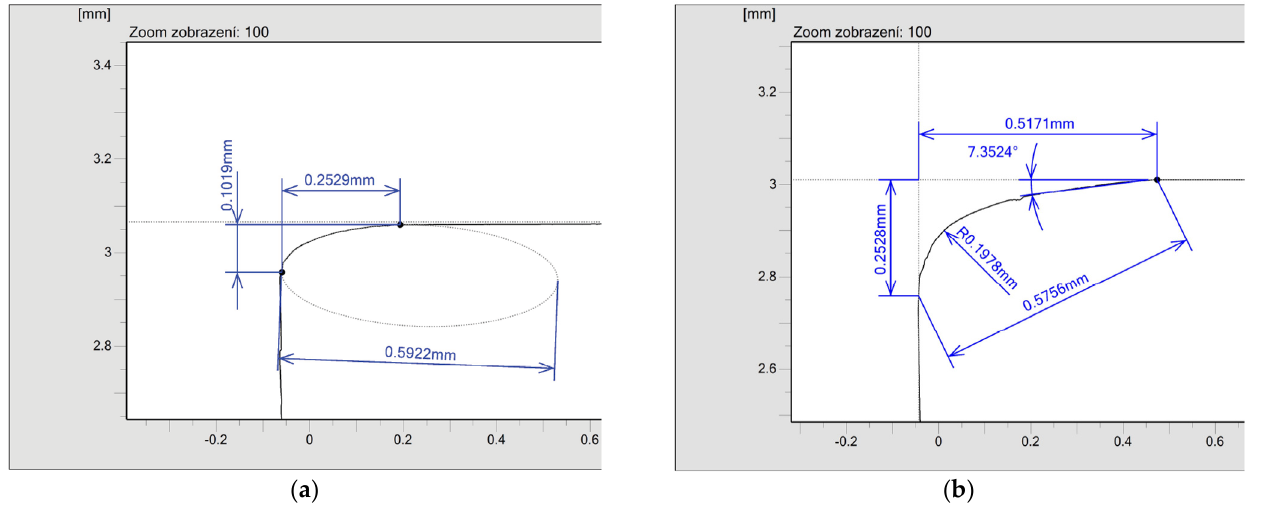
Figure 8. Dimensions of the created elliptical fillets: ( a ) 0.25 × 0.1 mm, ( b ) 0.5 × 0.2 mm.